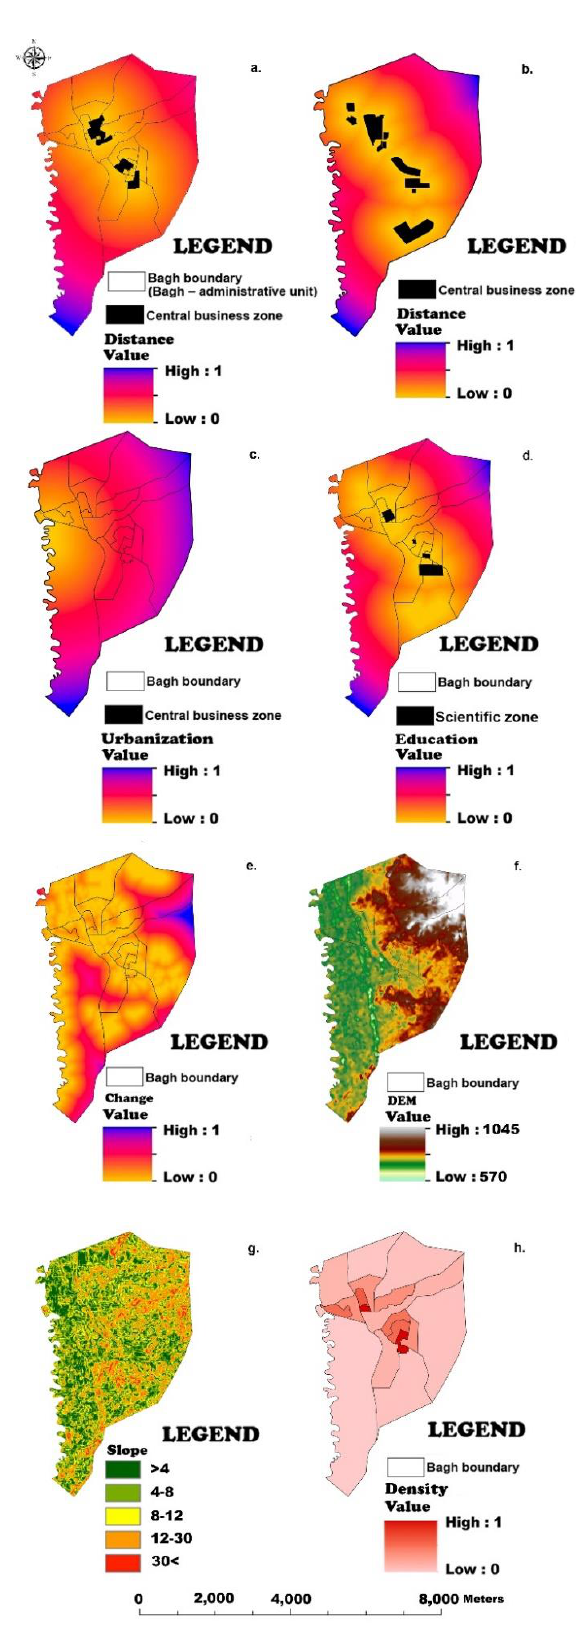
Figure 4. Variables affecting the urban expansion: a. Distances to the active economic center; b. Distance from the residential area; c. Distance to the nearest urbanization; d. Distances to the education zone; e. Distance from the road; f. Elevation; g. Slope; h. Population